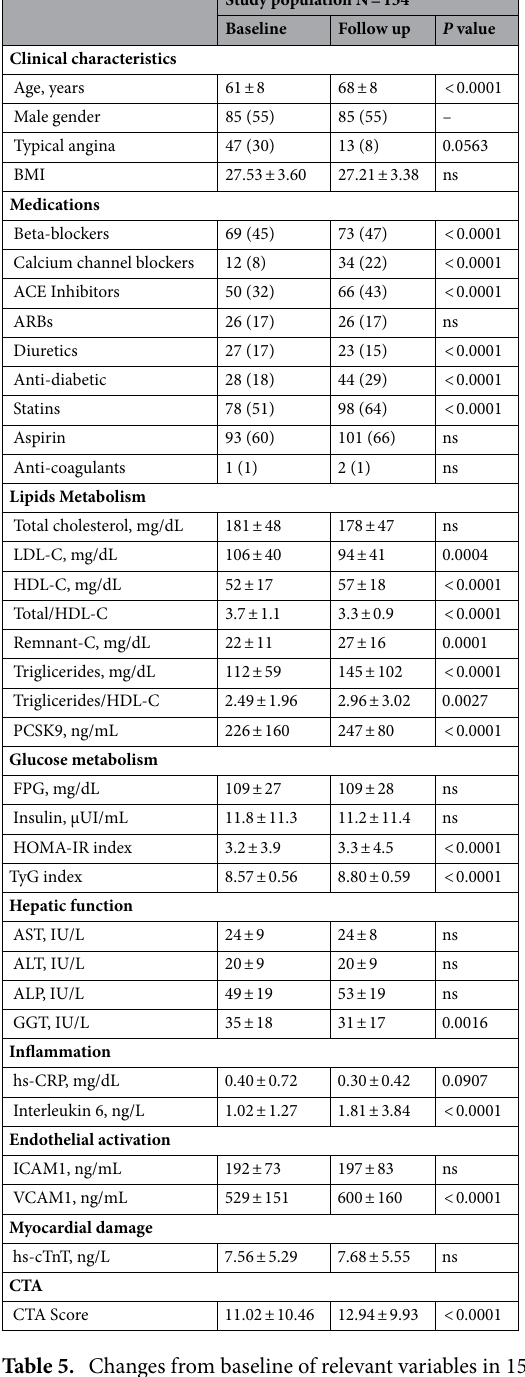
Table 5. Changes from baseline of relevant variables in 154 patients who performed a follow-up CTA. [Continuous variables are presented as mean ± standard deviation, categorical variables as absolute N and